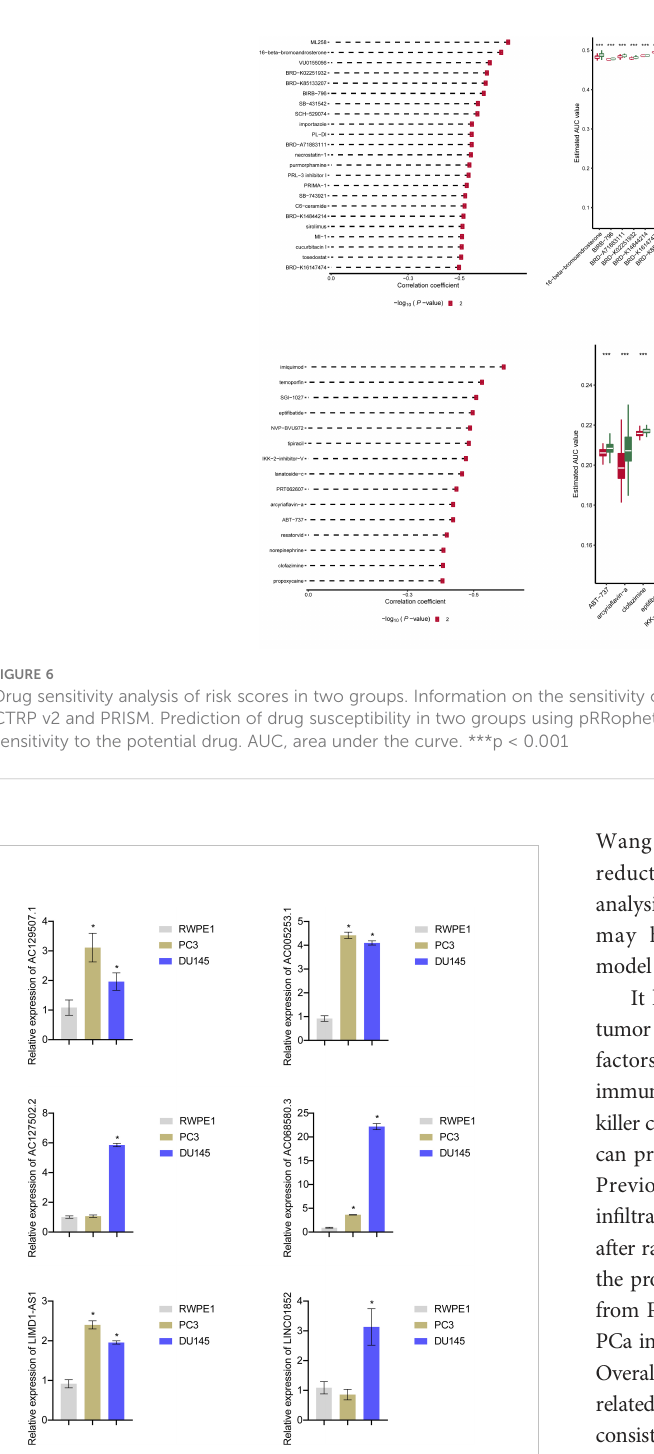
FIGURE 7 Risk score gene expression identi fi cation. RT-qPCR to detect the AC129507.1, AC005253.1, AC127502.2, AC068580.3, LIMD1-AS1, and LINC01852 expression in RWPE1, PC-3, and DU145 cell. *p < 0.05, vs.